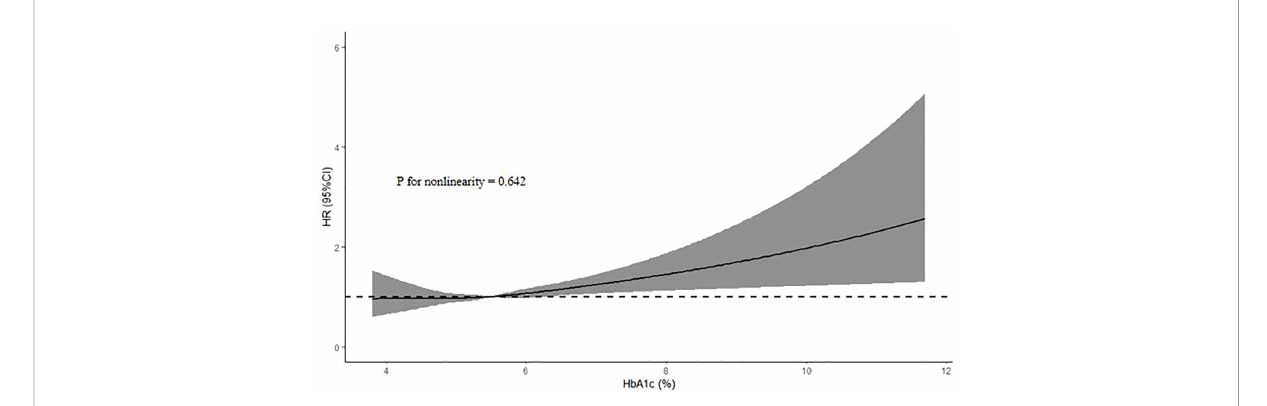
FIGURE 3 HR (95% CI) for the incidence of hypertension according to HbA1c. The association was adjusted for variables included in the multivariate adjusted models in Table 2. HbA1c, hemoglobin A1c; HR, hazard ratio; CI, con fi dence